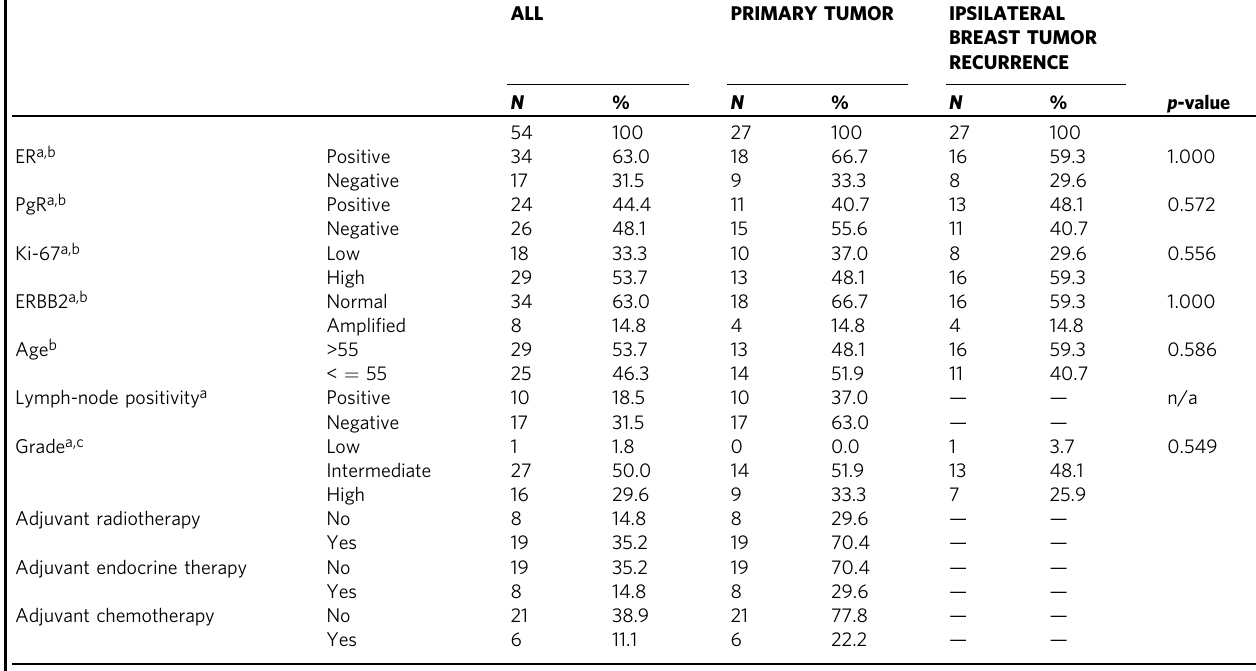
a Missing data b Fisher exact test c Chi-square test ER estrogen receptor, ERBB2/Her2 receptor tyrosine-protein kinase erbB-2, Ki-67 antigen Ki-67, PgR progesterone receptor, TP53 tumor protein